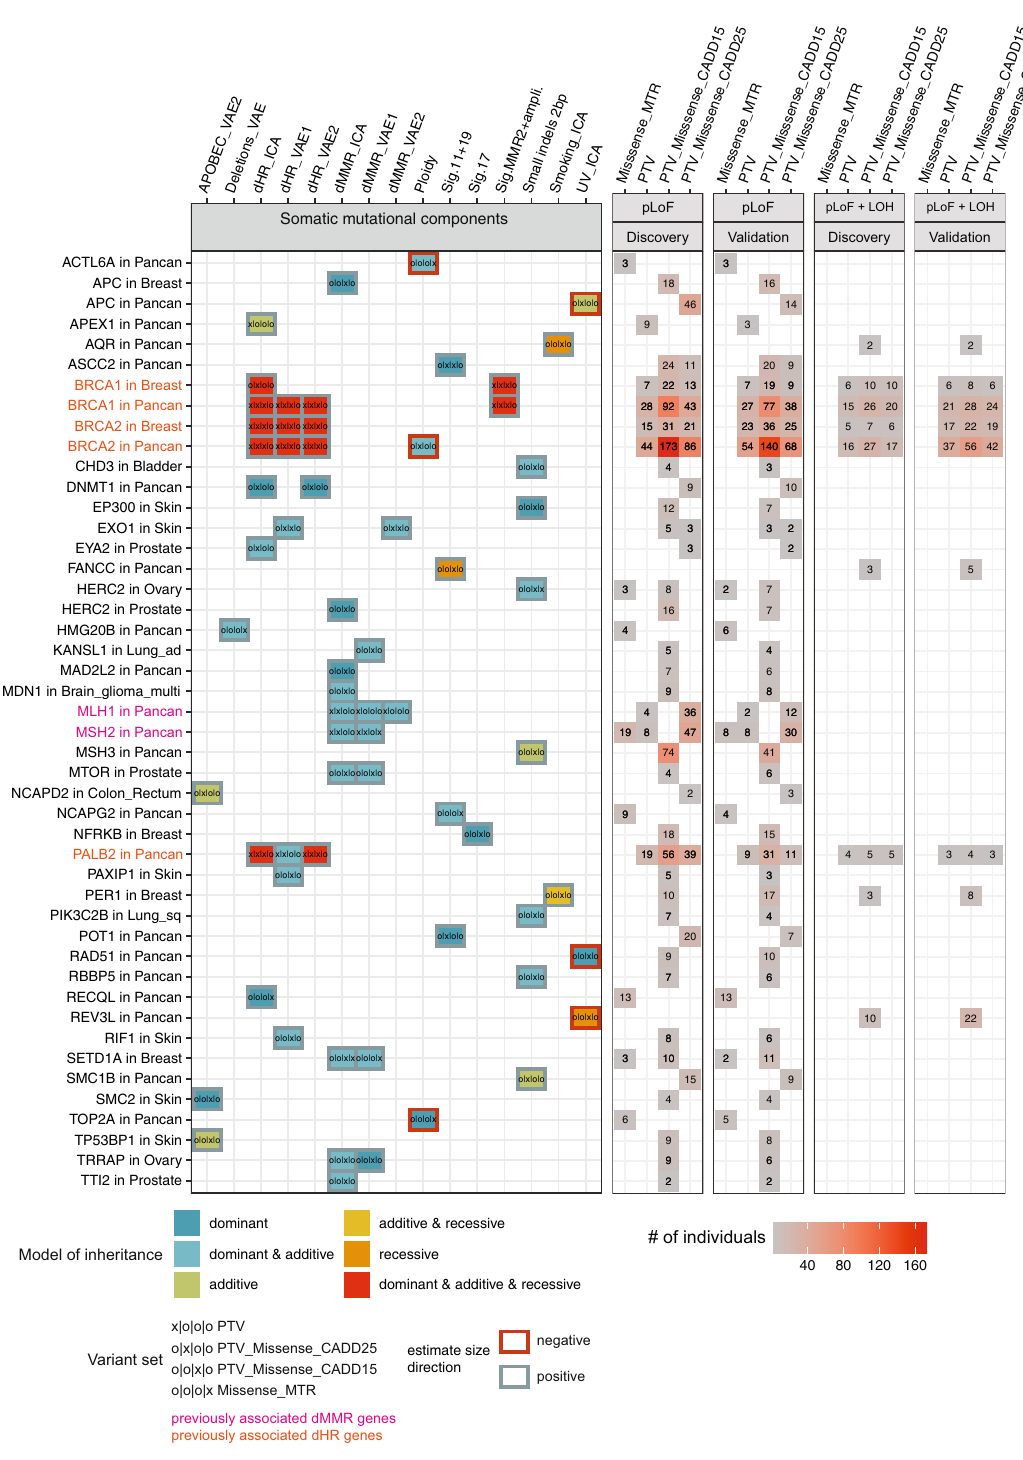
Fig. 3 Overview of replicated associations at a false discovery rate (FDR) of 1%. Gene-cancer type pairs ( x -axis) and the somatic mutational component ( y -axis 1st column) for which the association replicated at a 1% FDR. Corresponding rare putative loss-of-function (pLoF) variant set(s) are shown in each tile, where symbols and color code denote model(s) of inheritance by which they associated. Further, each tile shows the number of individuals carrying rare pLoF variants (2nd and 3rd column) or rare pLoF variants + somatic LOH (4th and 5th column) for the corresponding rare pLoF variant set associated. Gene – phenotype associations that have been previously identi fi ed are highlighted (pink for de fi cient DNA mismatch repair (dMMR) and orange for de fi cient homologous recombination (dHR)). Underlying data are provided as a Source Data fi